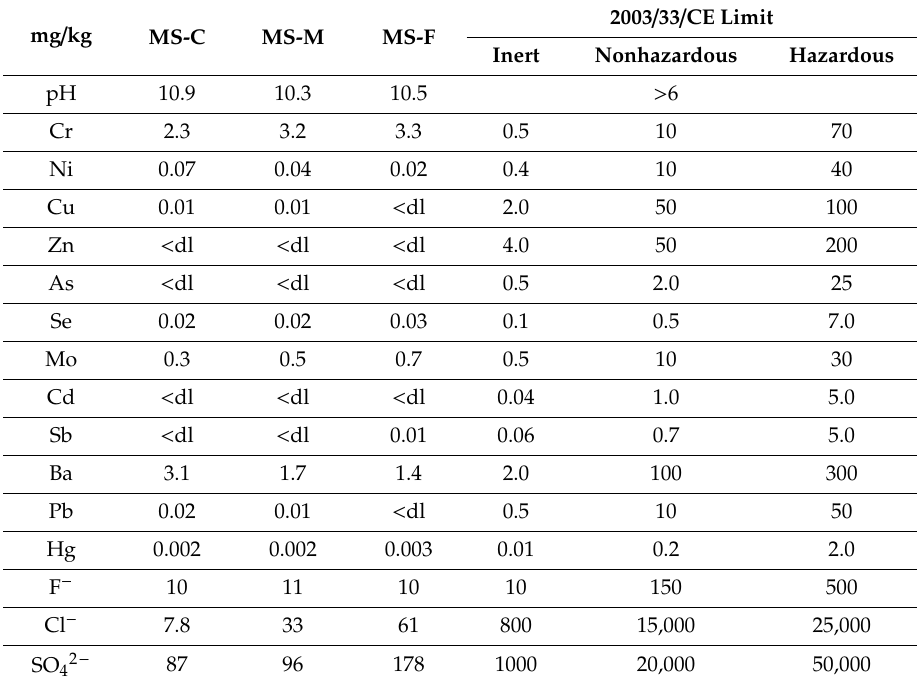
Table 3. Concentrations of potentially hazardous elements in the EN-12457 leachates of the acoustic materials compared with2003 / 33 / CE limit